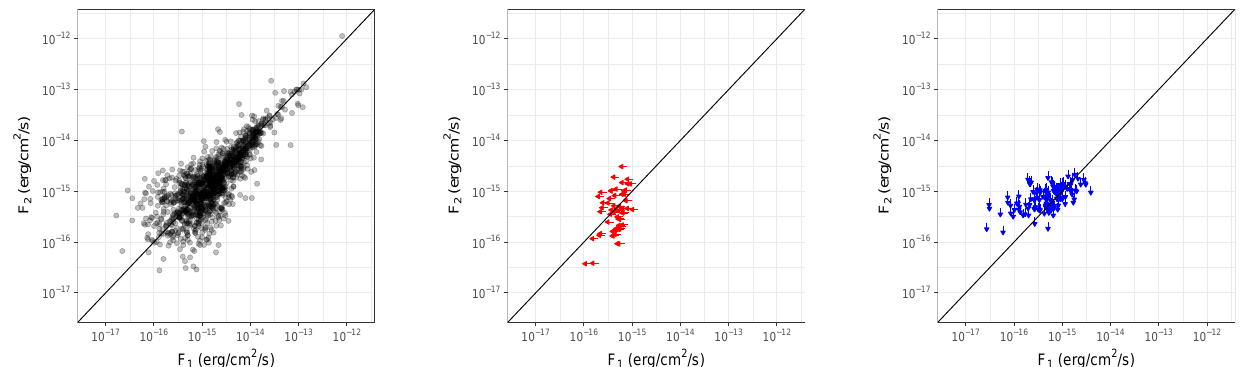
Fig. 2.— The fluxes of the AGN in the two observations for the full sample. Left: AGN with fluxes measured in both observations. Centre: AGN with upper limits on F 1 . Right: AGN with upper limits on F 2 . The solid line in each panel is a line of equality, and error bars are omitted for clarity. Upper limits are at the 1 σ